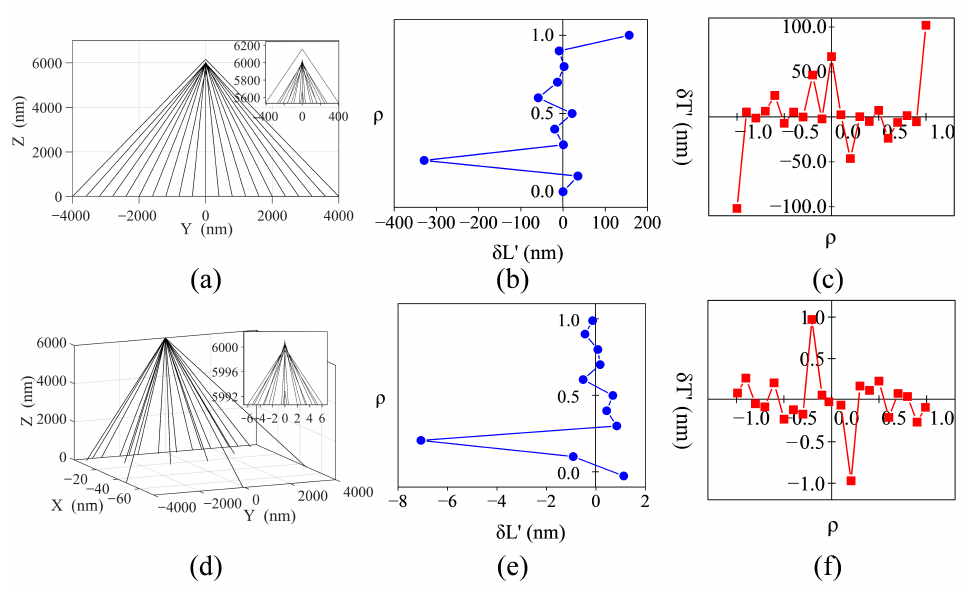
Figure 3. (Color online) The effects of phase correction on the metalens performance. ( a – c ) The light tracks, longitudinal and transverse spherical aberrations after single row nanopillars of the threshold- improved metalens. ( d – f ) Corresponding results after single row nanopillars of the optimized metalens. The blue and red lines are used to guide the